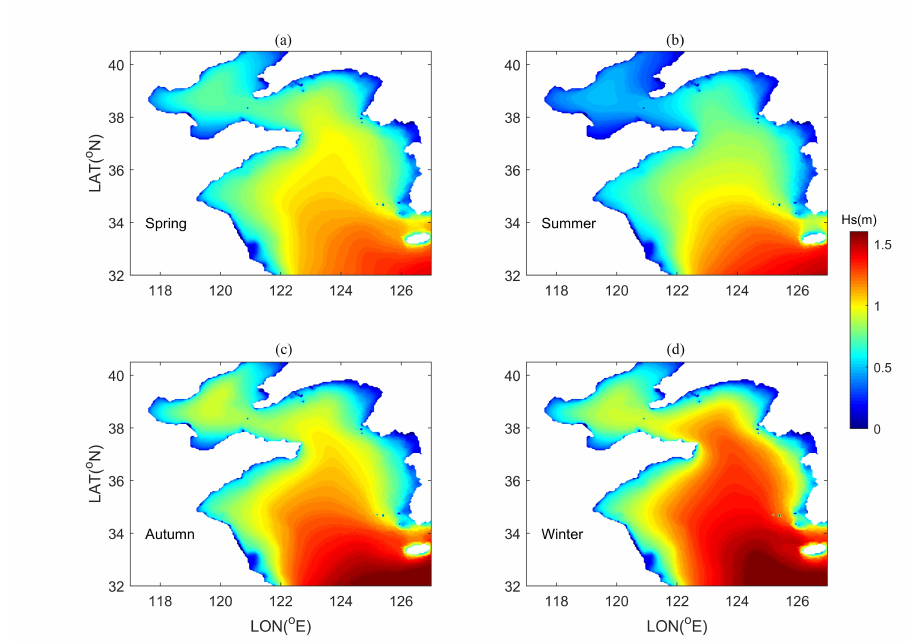
Figure 5. Distributions of seasonal mean Hs based on the hindcast from 1979 to 2018 (( a ) Spring; ( b ) Summer; ( c ) Autumn; ( d ) Winter).